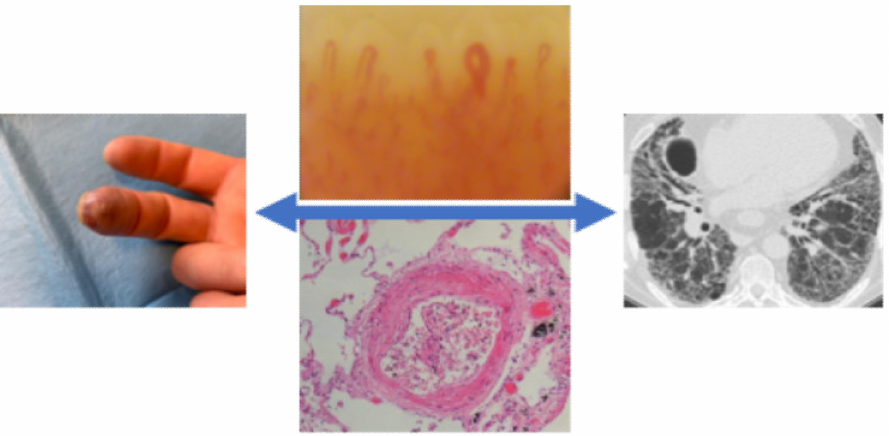
Figure 3. Vasculopathy in systemic sclerosis patients and the link between pulmonary damage and peripheral vascular